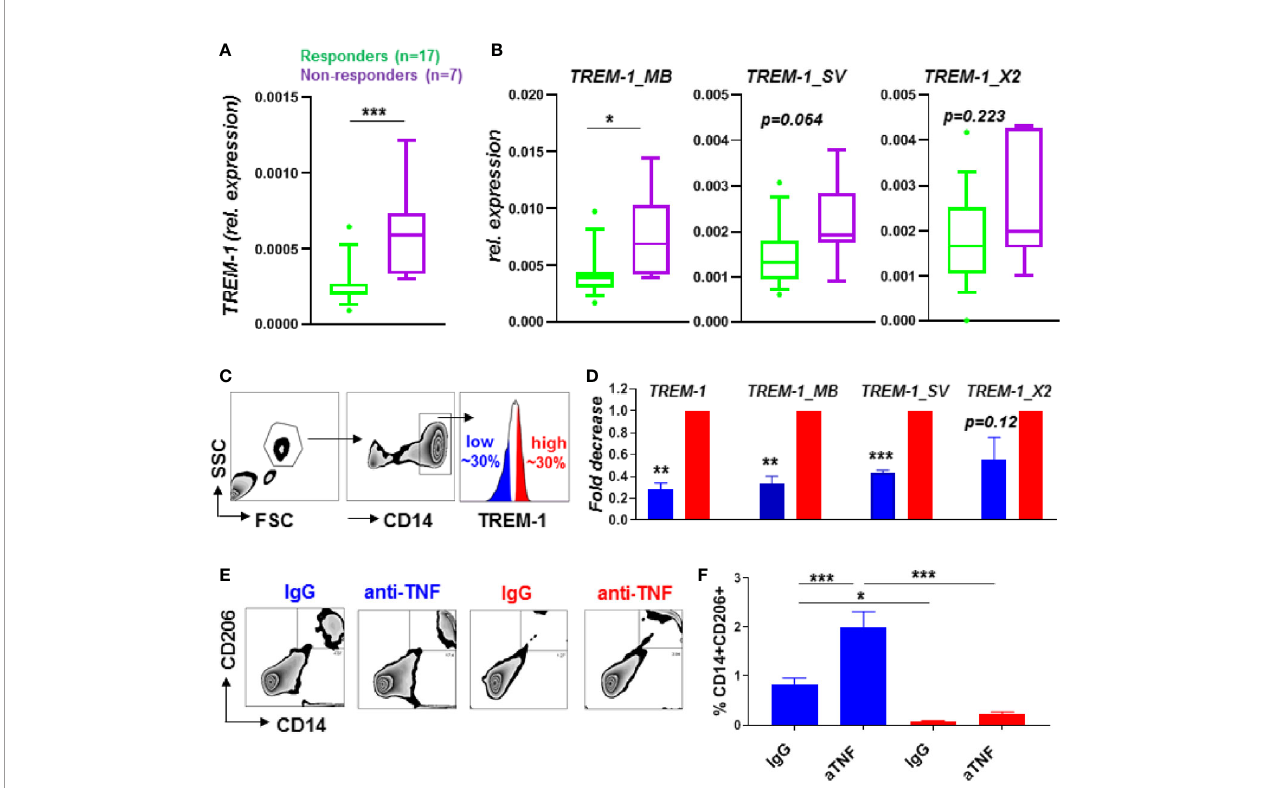
FIGURE 1 | TREM-1 levels in CD14+ monocytes are low in anti-TNF responders associated with a decreased M2 macrophage polarization by anti-TNF. Total TREM-1 expression (A) and the different TREM-1 isoforms TREM-1_MB, TREM-1_SV and TREM-1_X2 (B) expression levels in CD14+ monocytes from CD patients (n=24) before the start of anti-TNF therapy, and FACsorted (sort strategy in (C) ) CD14+ monocytes (n=4) with different TREM-1 levels (D) . Expression relative to bACTIN in (A, B) and relative to the TREM-1 high population in (D) . Percentage of CD206+CD14+ cells of TREM-1 low or high CD14+ monocytes cultured with T-cells of a different donor in combination with anti-TNF (adalumimab, 10 µg/ml) or IgG isotype control (10 µg/ml). Representative plots (E) , quanti fi ed in ( F , n=5 per condition) of 3 different independent experiments using different donors are shown. Whiskers indicate the 10-90 percentiles in (A, B) and de mean + SEM is shown in (D, F) . Signi fi cance was determined by a Mann Whitney (A, B) , paired-t-test (D) and ANOVA followed by Sidak ’ s multiple comparison test (F) with *P < 0.05, **P < 0.01, ***P <